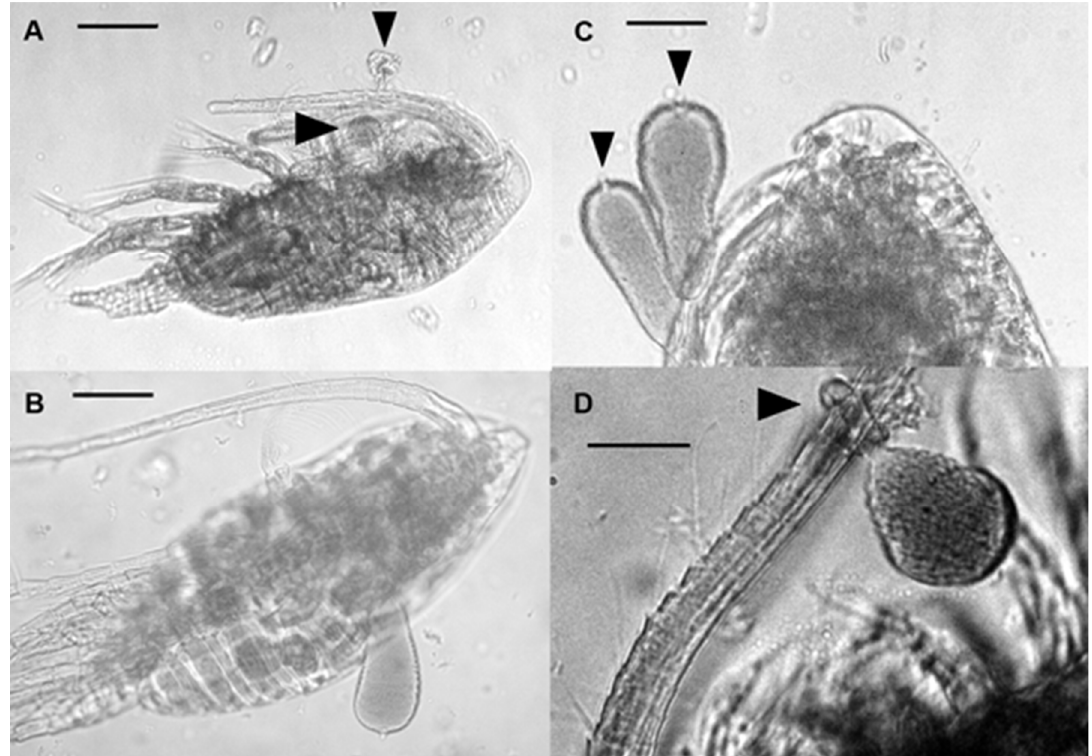
Figure 1. Paracalanid copepods infected by Ellobiopsis chattoni : ( A ) Paracalanus indicus with two adhered parasites; ( B ) P. indicus showing E. chattoni adhering to a mouth appendage; ( C , D ) Parvocalanus crassirostris with parasites attached to the antenna. ( A , B ) Scale = 200 μ m; ( C ) scale = 80 μ m; ( D ) scale = 60 μ m.